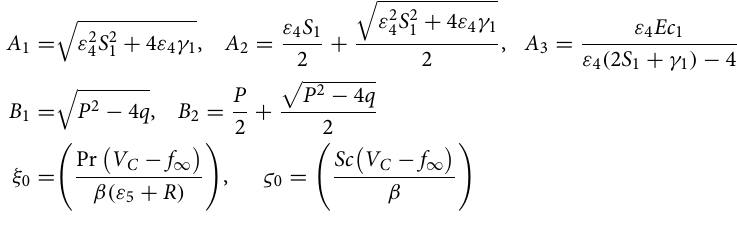
for more values of V C . Also f η (η) less for more values of V C . The effect of θ(η) on η for various values of (cid:31) , I , and Da − 1 is respectively represented at Fig. 11a–c. Here, θ(η) more for more values of (cid:31) and Da − 1 , but θ(η) less for more values of I . And also we observe that after certain values of (cid:31) lines are merging each other. The effect of φ(η) on η for different choices of Sc , δ , and V C is respectively represented at Fig. 12a–c. from these graphs it is cleared that φ(η) decreases with increasing the values of Sc , δ , and V C . The inclusion of porous media, heat source/sink parameter, thermal radiation and mass transpiration greatly useful in many fields, porous media prevents heat loss/gain and also accelerates the heat source/sink. Heat source/sink results in thinning of the thermal boundary, Marangoni convection results in more induced